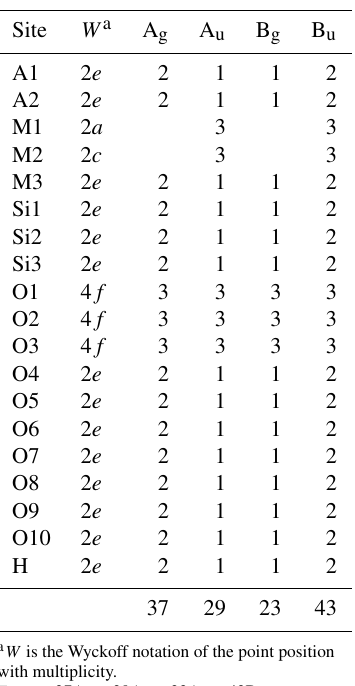
Table 3. Symmetry types of Brillouin-zone phonon modes for epidote-supergroup